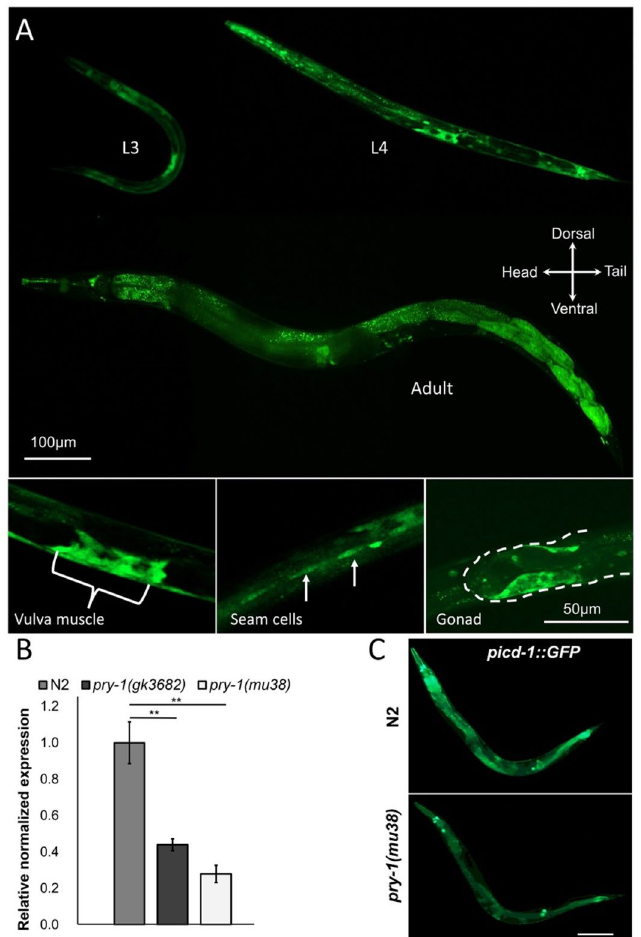
Figure 4. Expression analysis of picd-1 . ( A ) Representative images of animals expressing picd-1::GFP in larvae and adults. Tissues that show fluorescence include pharynx, gonad, hypodermis, intestine, vulva, body wall muscles, and some in the tail region. Scale bars are shown. ( B ) Expression levels of picd-1 in pry-1 mutants. Data represent the means of two replicates and error bars represent the standard error of means. p values were calculated using Bio-Rad software (one-way ANOVA). In panel ( B ) significant differences are indicated by stars (*): ** ( p < 0.01). ( C ) Representative images of N2 and pry-1(mu38) adults showing picd-1::GFP expression . Scale bar is 100